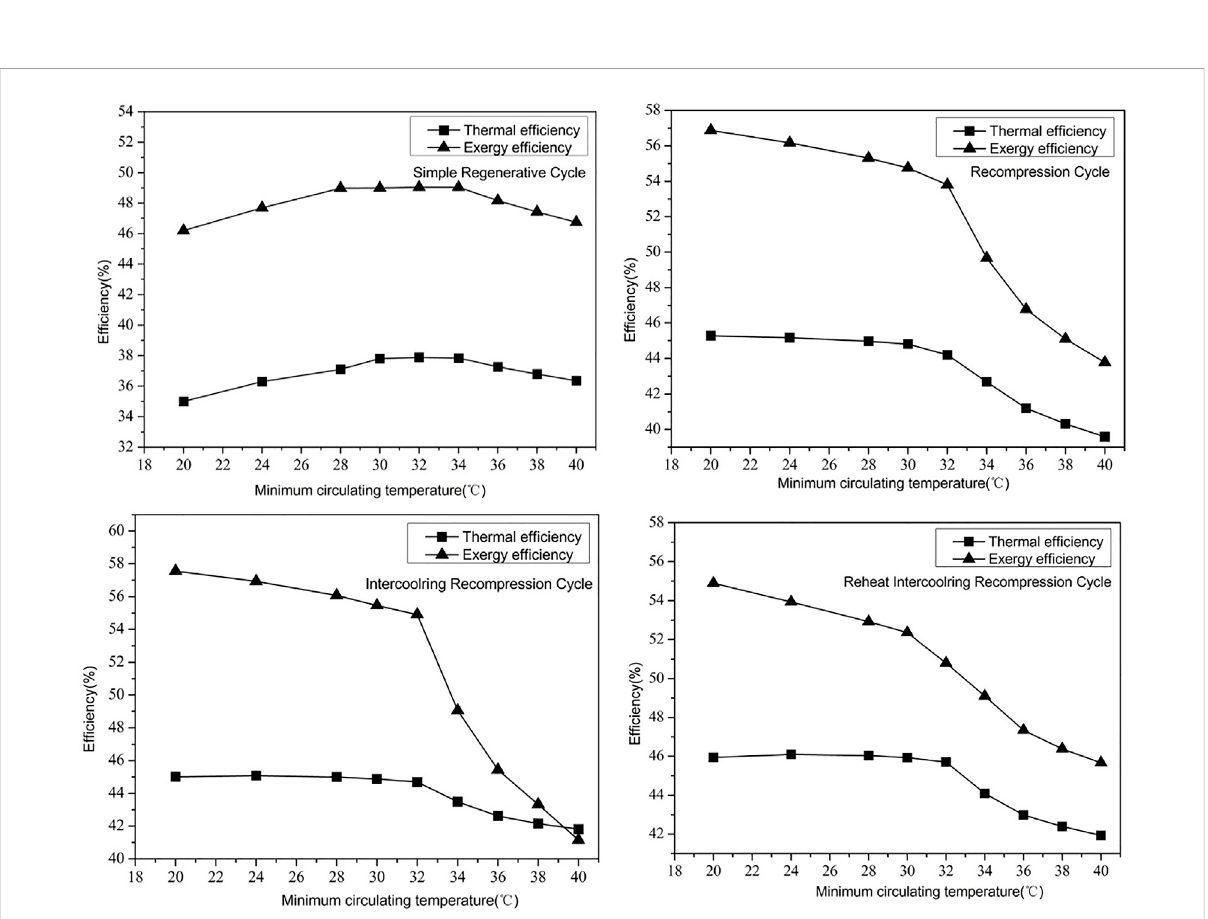
FIGURE 12 Ef fi ciency of different con fi gurations at different cycle minimum